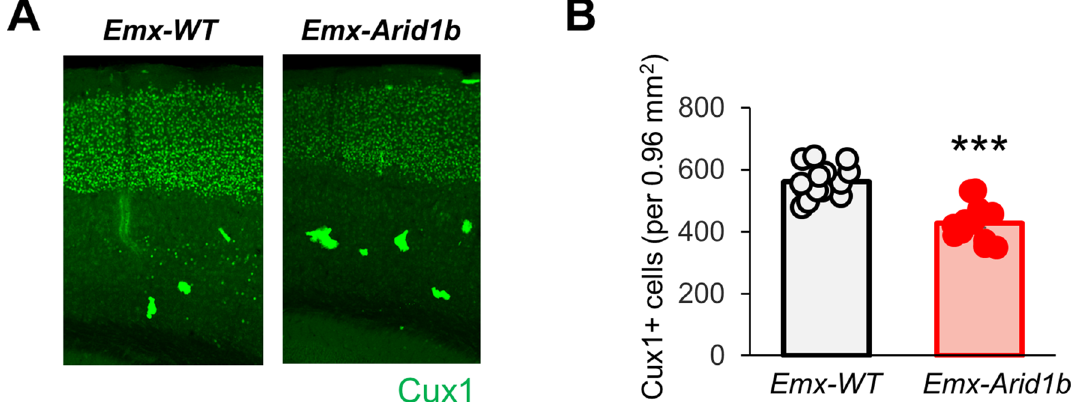
Figure 4. Arid1b deletion in cortical progenitors leads to a reduction in upper layer neurons. ( A ) Cortical sections of P30 control and Emx-Arid1b mice were immunostained using an anti-Cux1 antibody. ( B ) Quantification of ( A ). The number of Cux1-positive neurons was decreased in Emx-Arid1b mice. N = 15 for each genotype. Statistical significance was determined by two-tailed Student’s t test. Error bars show SEM. *** p <